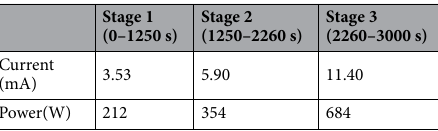
Table 3. The duration, beam power and beam power of the